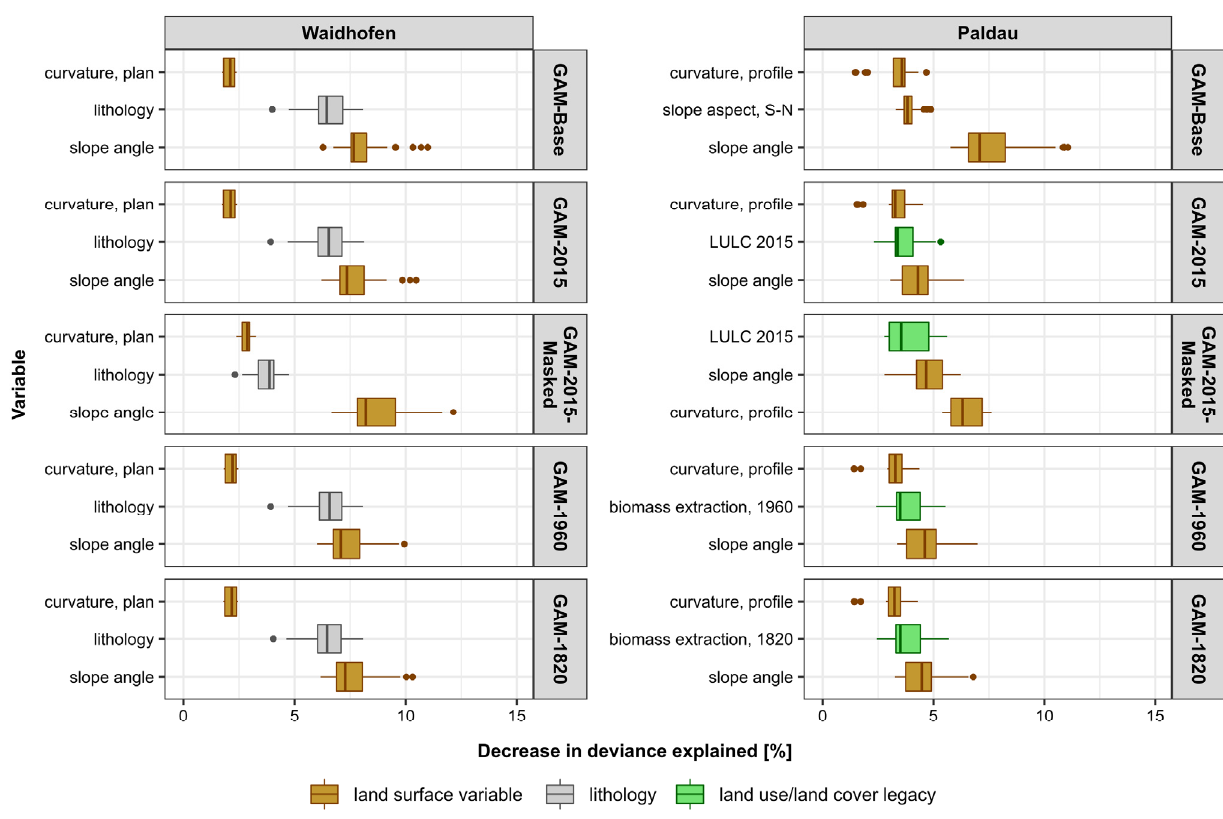
Figure 4. The three most important variables in terms of decrease in deviance explained [%]. Refer to Table A6 in the Appendix B for an overview of variable importance for all predictor variables.